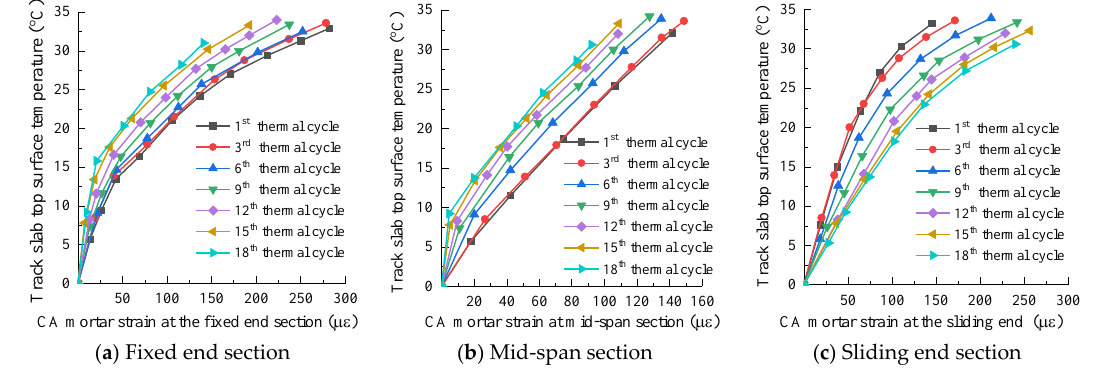
Figure 13. CA mortar strain variation with the thermal load.